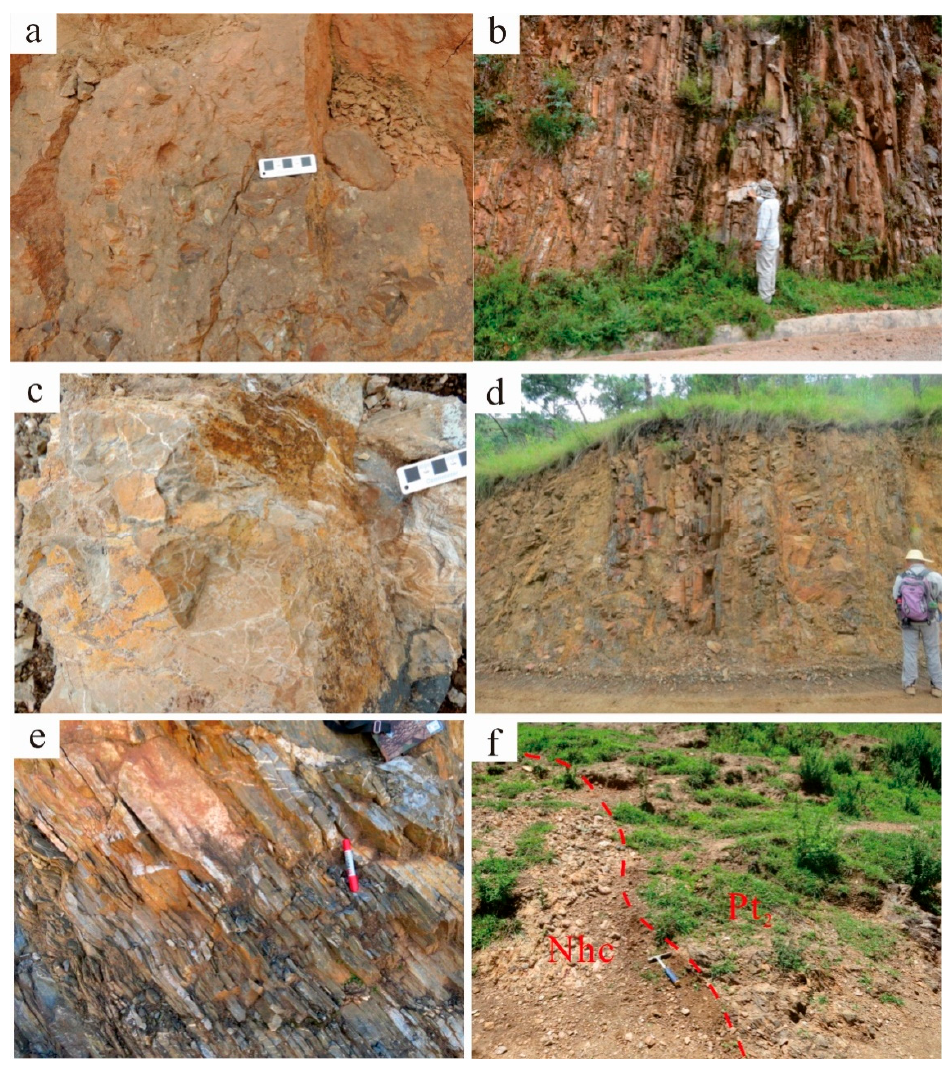
Figure 3. ( a ) Glutenite in the Yinmin Formation; ( b ) sandstone in the Yinmin Formation; ( c ) algal dolomite in the Luoxue Formation; ( d ) carbonaceous slate in the Heishan Formation; ( e ) dolomite and limestone in the Qinglongshan Formation; ( f ) unconformable contact between the Chengjiang Formation and the Qinglongshan